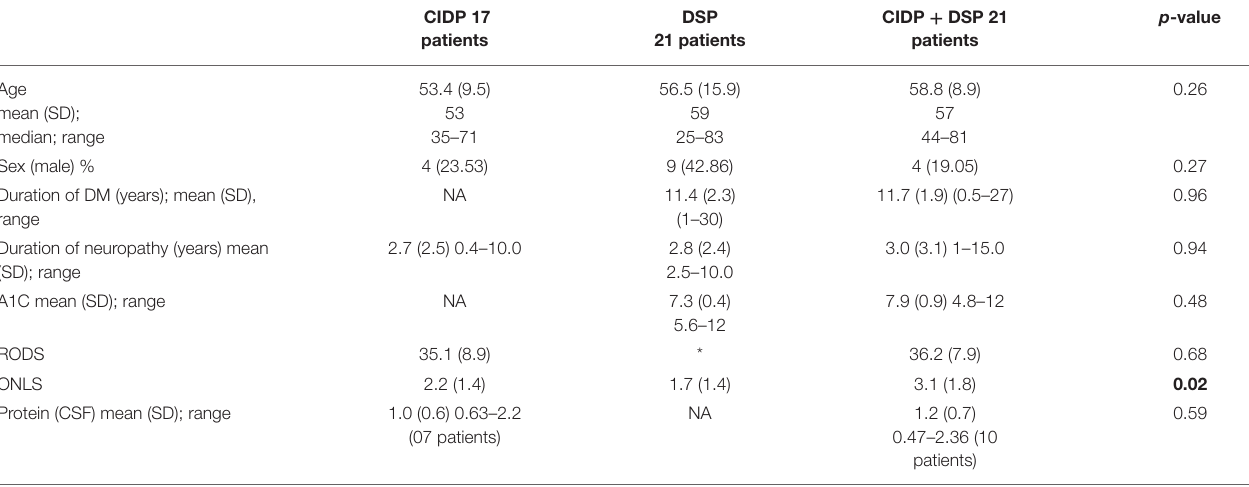
TABLE 1 | Demographic and clinical profile of CIDP, DSP and CIDP + DSP